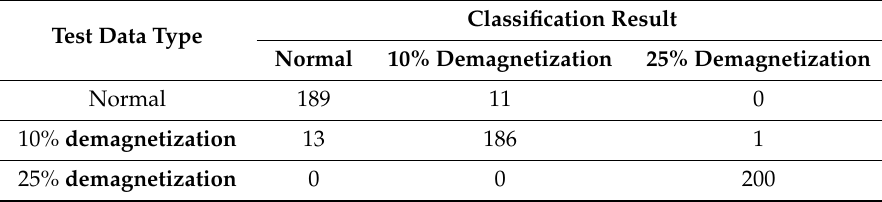
Table 9. Confusion matrix of test dataset.